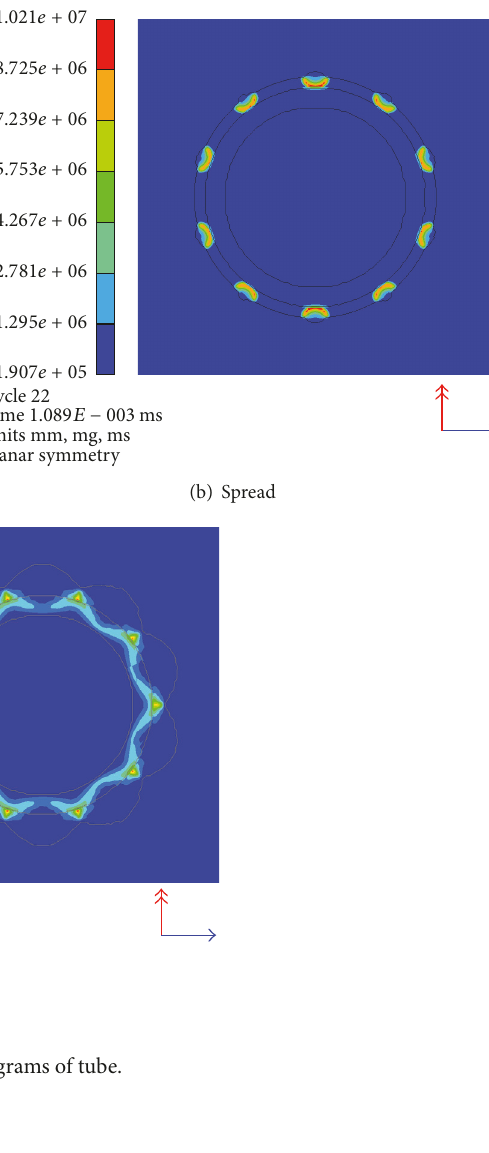
3.2.2. Deformation and Fracture. Figure 14 depicts the state of the tube under explosive loading. In this study, the Grade spall mode was adopted to investigate the fracture, assuming a critical strain of 0.15. At 6.03 × 10 −3 ms, the tube spalled in the collision region, and the cracks increased with tensile stress. Comparisons were done between the numerical analysis and the experiment. The number of spall cracks of the experiment was 6, the thickness of spall was about 4 mm, and the width and length of the cracks were about 3 mm and 6 mm, respectively, while a total of ten spalls were formed in the numerical analysis, each with a thickness of approximately 6 mm. The width and length of the cracks were about 3 mm and 6 mm, respectively, too. The results indicated that the shapes of spall were similar, but the amounts were inconsistent. Analysis showed that the numerical calculation of the Figure 11: Pressure on exterior of tube. material was fully isotropic, and the load was